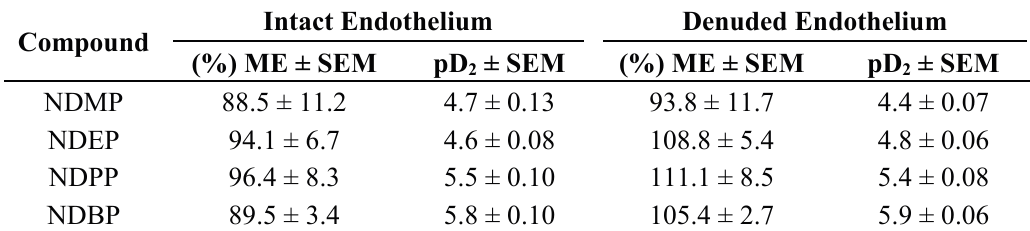
Table 1. Maximum effect (ME) and sensibility (pD 2 ) values regarding the vasorelaxant effect of the new organic nitrates derived from glycerin in superior mesenteric artery isolated from rats precontracted with phenyleprine, in the presence or absence of functional endothelium (n = 6 for each group)